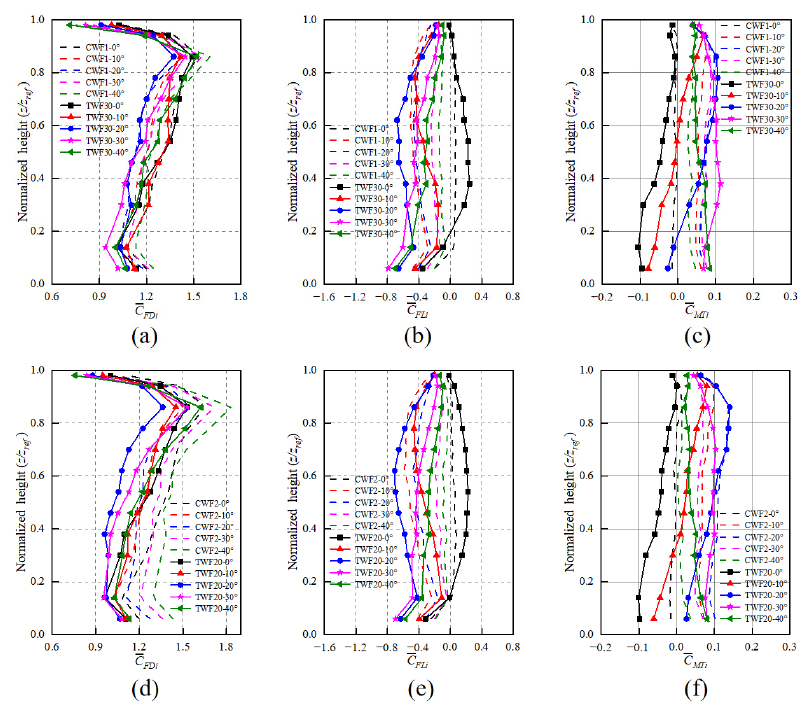
Figure 13. Variations of C FDi , C FLi , C MTi with height: ( a – c ) in TWF30 and CWF1; and ( d – f ) in TWF20 and CWF2.